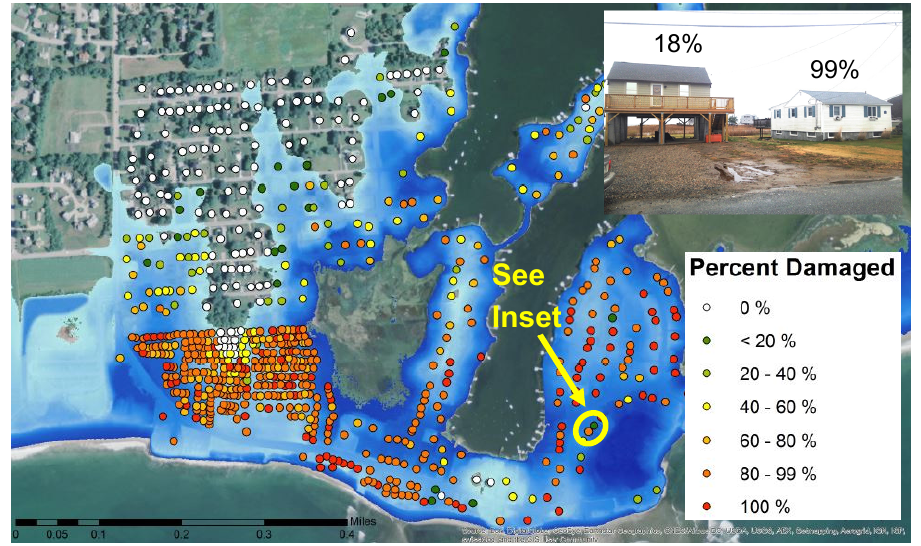
Figure 15. Total estimated damage to each structure from a 100 year storm event with 7 feet of sea level rise. The extent of inundation is also shown.